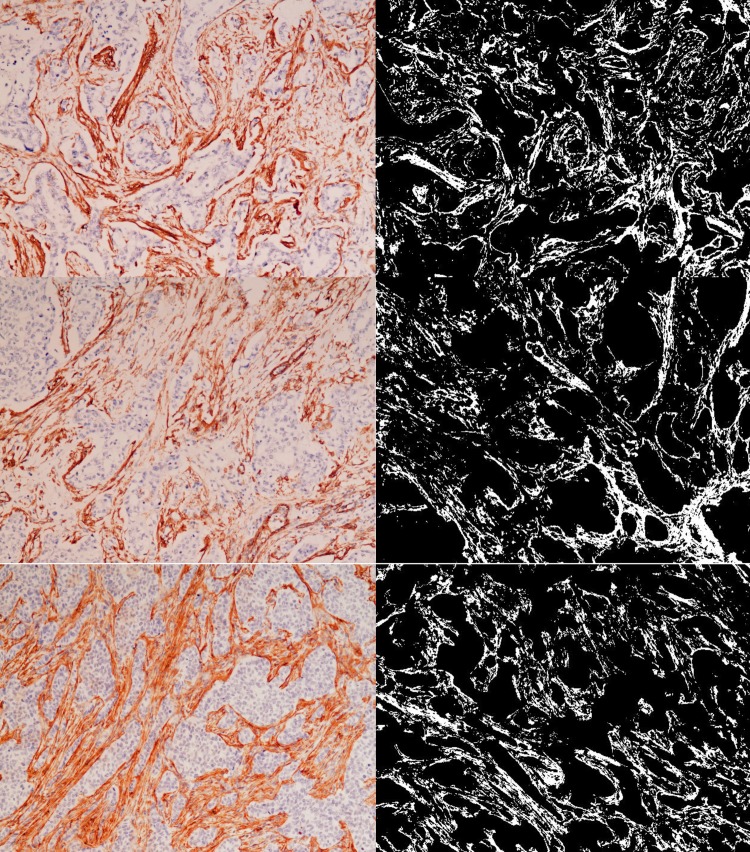
Stromal SMA expression.Immunohistochemical staining of SMA in tumor stroma (left side) and the corresponding image obtained with DIA (right side).